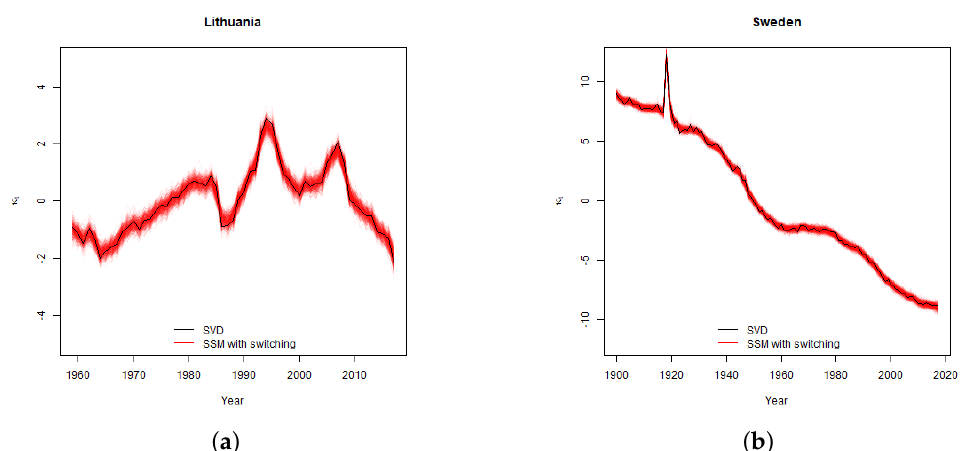
Figure 2. Estimation of the parameter κ t for Lithuania ( a ) and Sweden ( b ). The black line represents the classical Lee-Carter model SVD estimate and the red lines are FFBS samples of 500 MCMC iterations of the SSM with